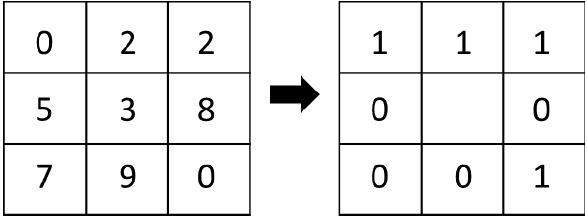
Figure 1. The bit string construction of